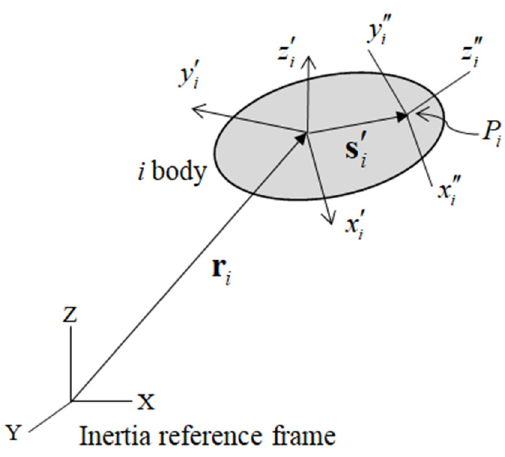
Figure 2. Kinematic relationships among mining system bodies [17].